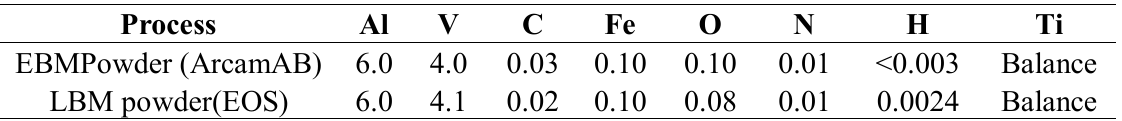
Table 2. Nominal chemical composition (w/o) of the Ti-6Al-4V ELI powder used for EBM and LBM